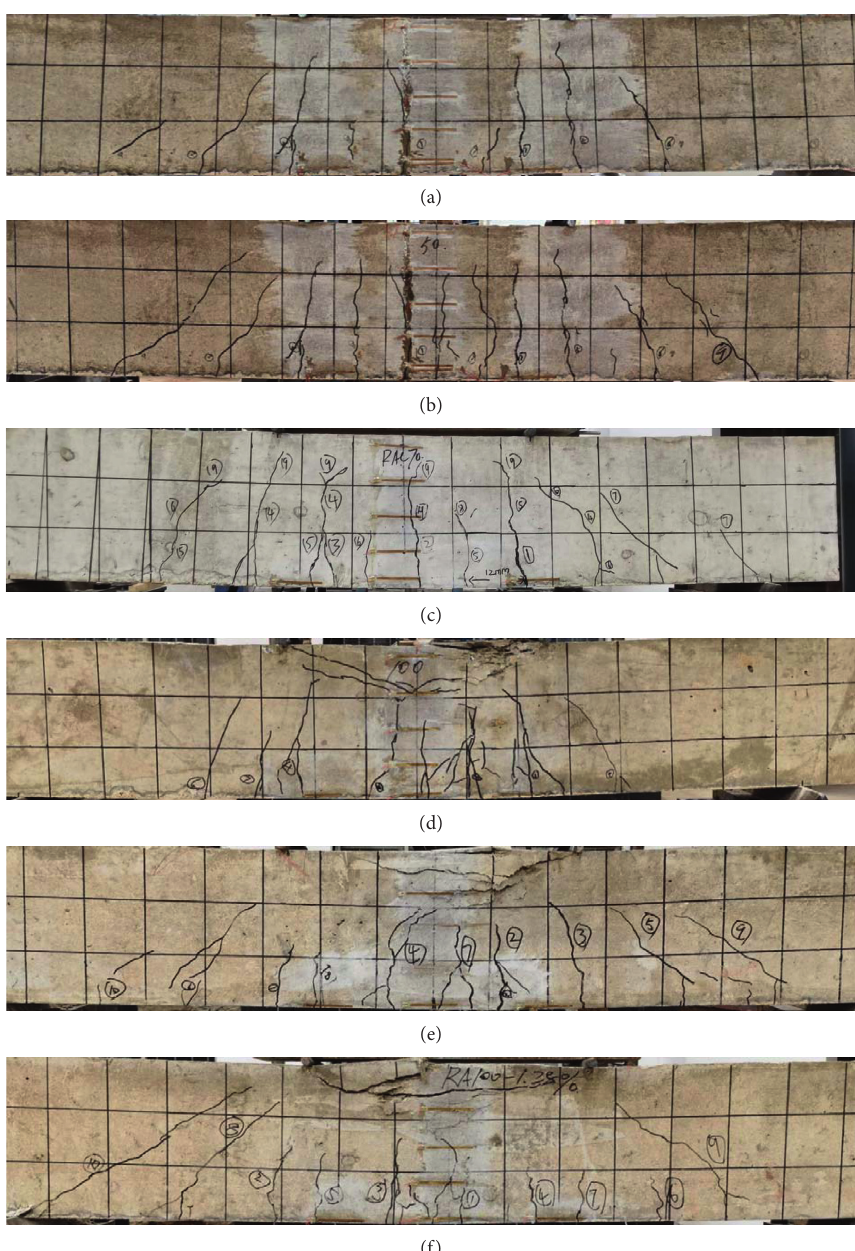
Figure 8: Variations of crack spacing of RAC beams. (a) Substitution ratio of RCA. (b) Reinforcement ratio of tensile